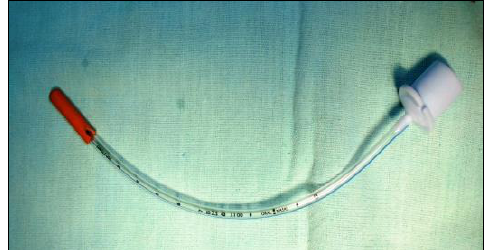
Figure 2: Broken tip of red rubber catheter engaged at the tip of endotracheal tube which was removed